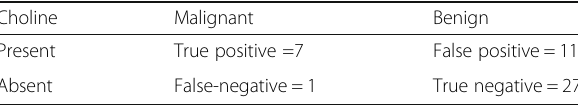
Table 2 Table for the significance of the presence of choline peak in benign and malignant lesions ( p value< 0.005)